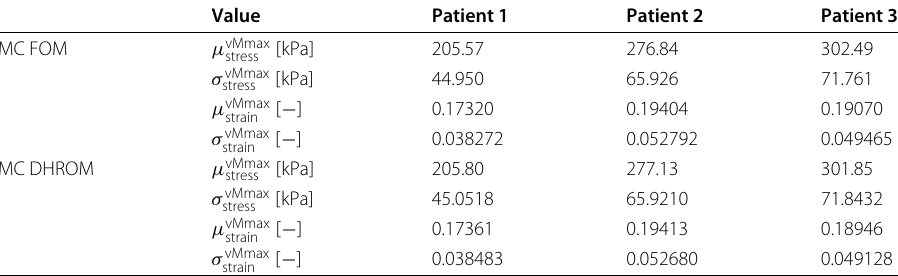
Table 5 Mean values μ vMmax and standard deviations σ vMmax with x ∈ { stress , strain } for maximum x x von Mises stress and maximum von Mises strain in the aortic wall computed from Monte Carlo sampling with 10000 identical (per patient) samples. The corresponding parametric configurations are drawn from patient-specific probability distributions Value Patient 1 Patient 2 Patient 3 MC FOM μ vMmax stress [kPa] 205.57 276.84 302.49 σ vMmax stress [kPa] 44.950 65.926 71.761 μ vMmax [ − ] 0.17320 0.19404 0.19070 strain σ vMmax [ − ] 0.038272 0.052792 0.049465 strain MC DHROM μ vMmax stress [kPa] 205.80 277.13 301.85 σ vMmax stress [kPa] 45.0518 65.9210 71.8432 μ vMmax [ − ] 0.17361 0.19413 0.18946 strain σ vMmax [ − ] 0.038483 0.052680 strain